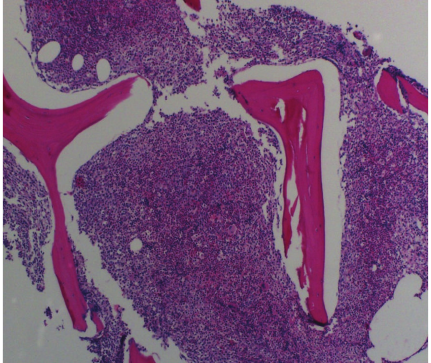
Figure 3: Bone marrow biopsy reveals a markedly hypercellular